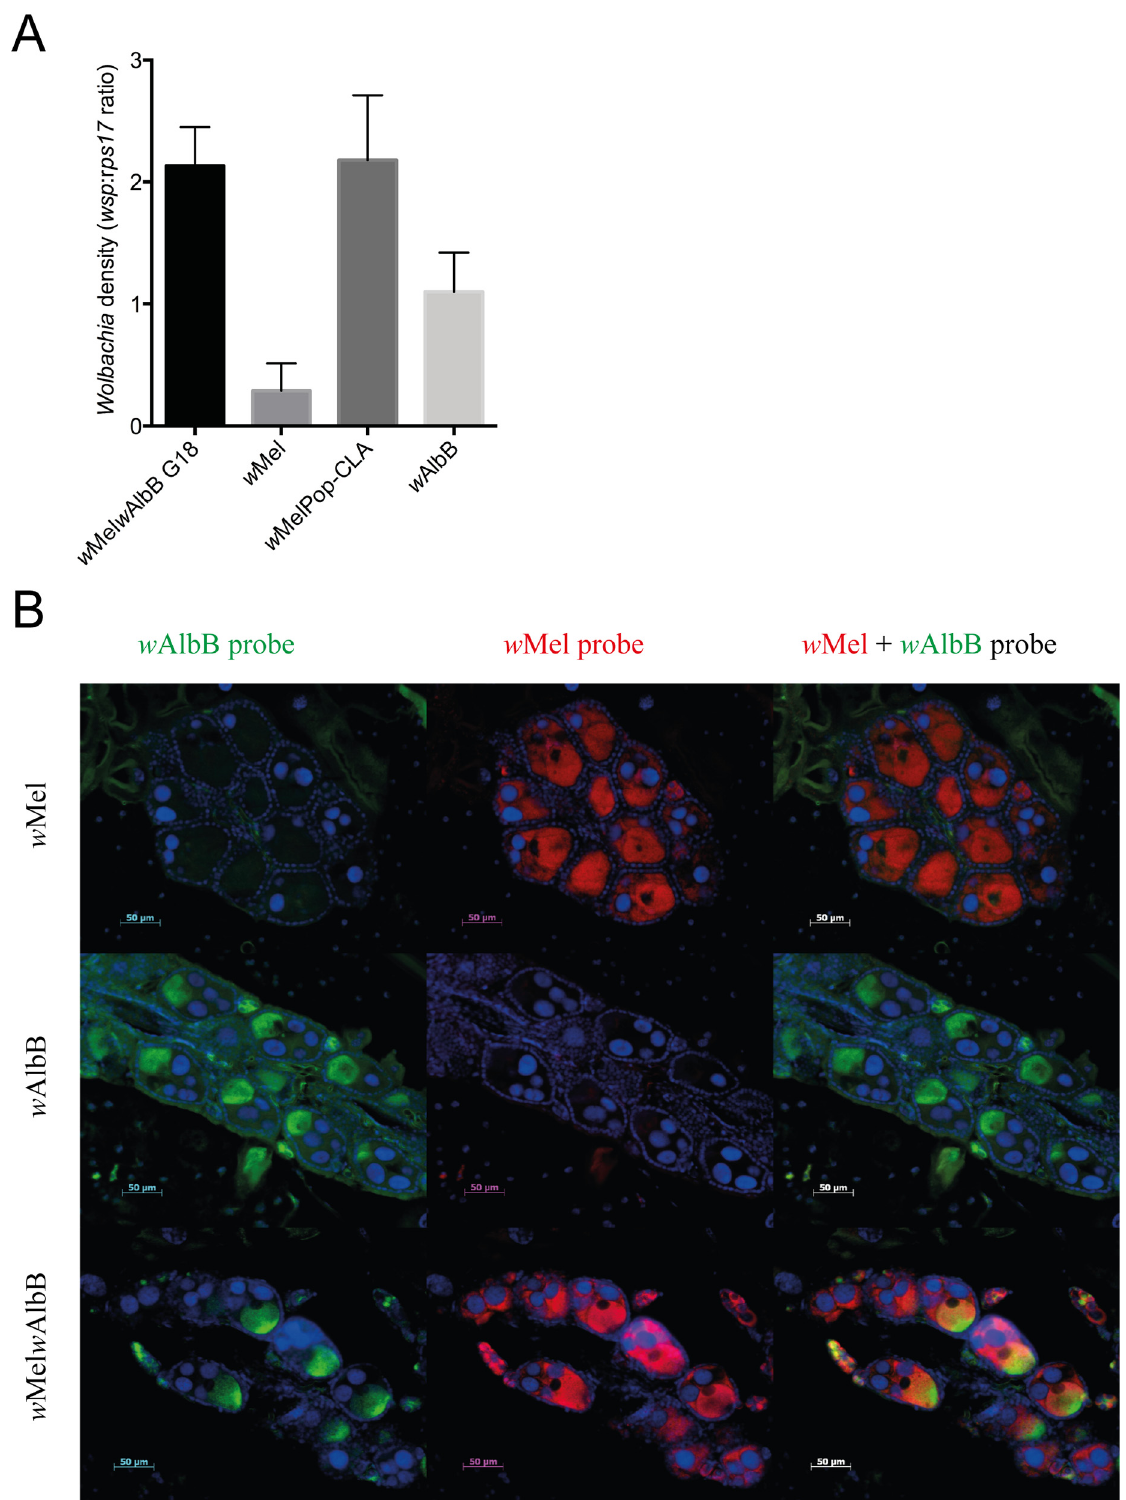
Fig 1. Wolbachia density and distribution in the Ae . aegypti superinfected line. (A) Comparison of total Wolbachia density between w Mel w AlbB (G18), w Mel, w AlbB and w MelPop-CLA infected mosquitoes. Density is expressed as the mean ratio between the w Mel or w AlbB wsp gene and the Ae . aegypti host rps17 gene. Standard error of the mean is indicated (n = 10). (B) Wolbachia distribution in the ovaries of w Mel, w AlbB and w Mel w AlbB infected adult female mosquitoes. Wolbachia was visualised using FISH with probes specific to w Mel (red) and w AlbB (green). DNA is stained in blue using DAPI. doi:10.1371/journal.ppat.1005434.g001 PLOS Pathogens | DOI:10.1371/journal.ppat.1005434 February 18,